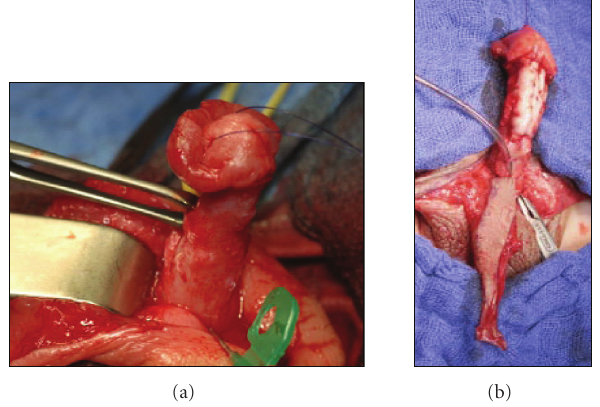
Figure 7: Straightening of the penis (a). The mucosal inlay graft is fixed on the cavernous bodies (b). The longitudinal island flap is ready for the onlay anastomosis